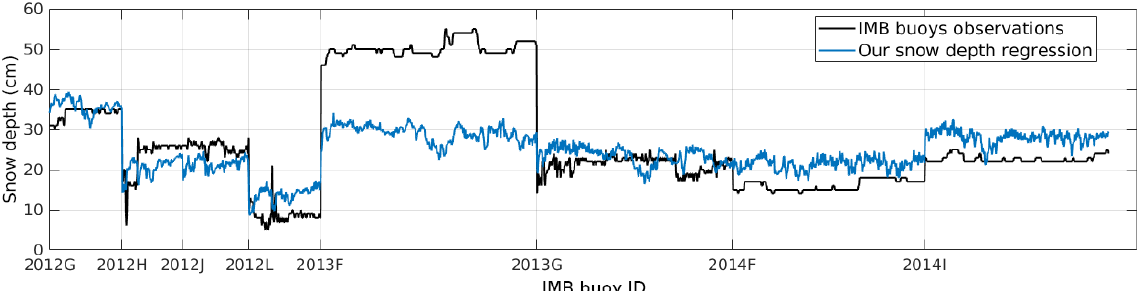
Figure 2. Time series of the comparison between snow depths from IMB observations and our multilinear regression (Eq. 2). The beginning of the measurements with a new IMB is indicated on the x axis.